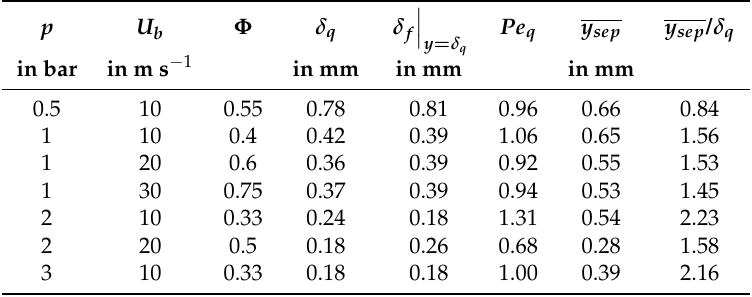
Table 2. Quenching and separation parameters at flashback